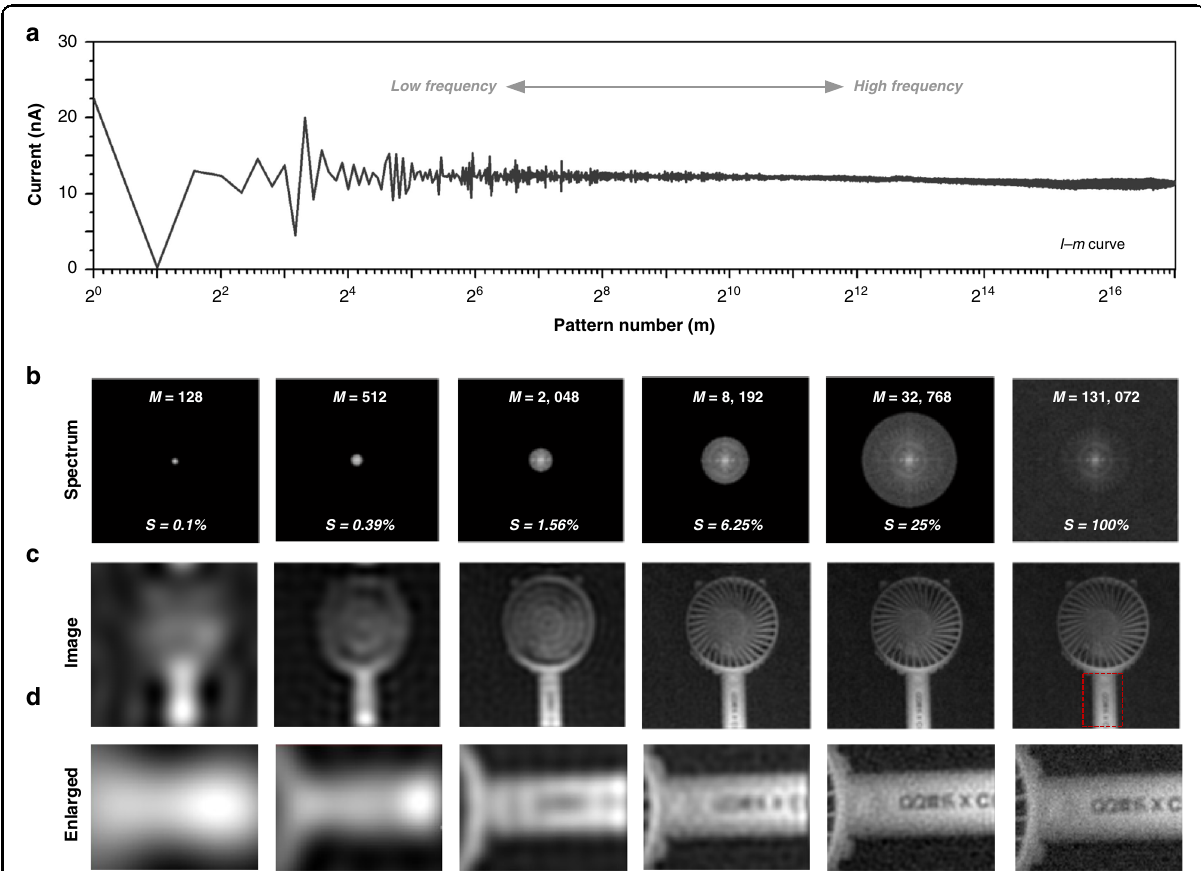
Fig. 3 Demonstration of high-resolution imaging with 256 × 256-pixels. a Obtained I-m curve ( M = 1: 131, 072, and 1 point per pattern) by the perovskite W PD. b Fourier coef fi cient spectrum (logarithmic modulus) when the measurement number ( M ) increases (from left to right). c The corresponding reconstructed image. d The enlarged